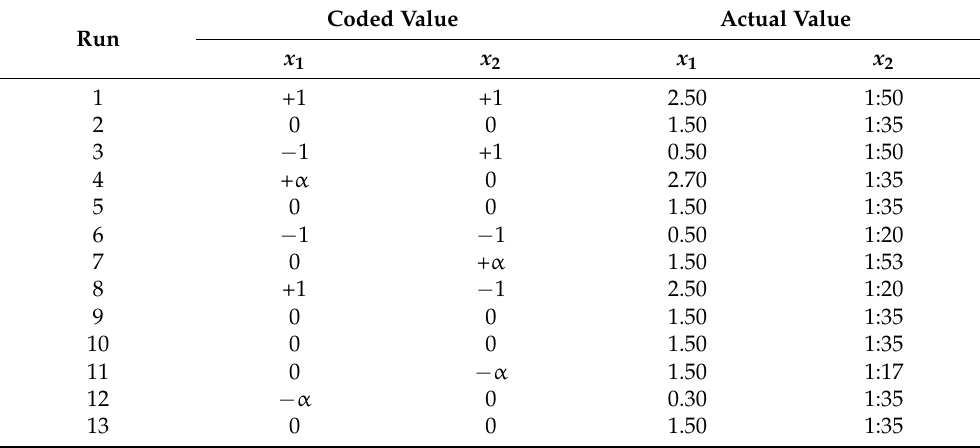
Table 3. Experimental design of a 5-level and 2-variable central composition design.